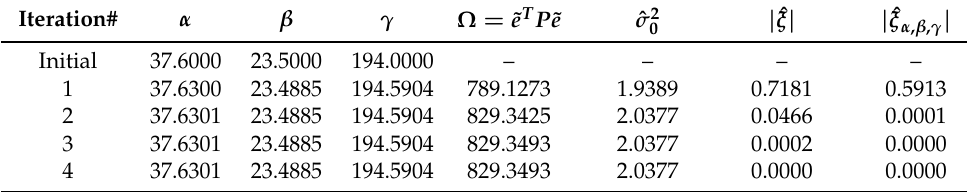
Table 3. Outputs of each iteration process (primary parameters only).